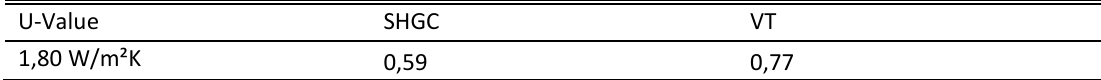
Table 8 Optical properties of Low-E coated